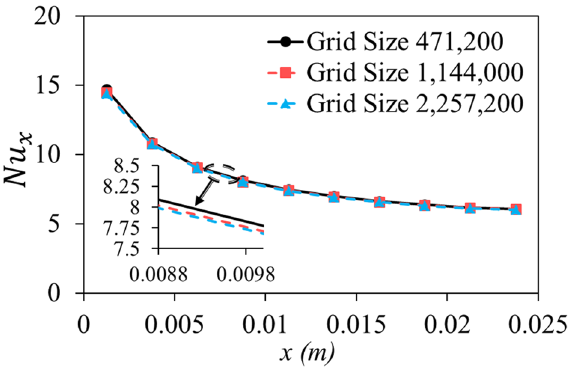
Figure 4. The local Nusselt number for grid independency examination.